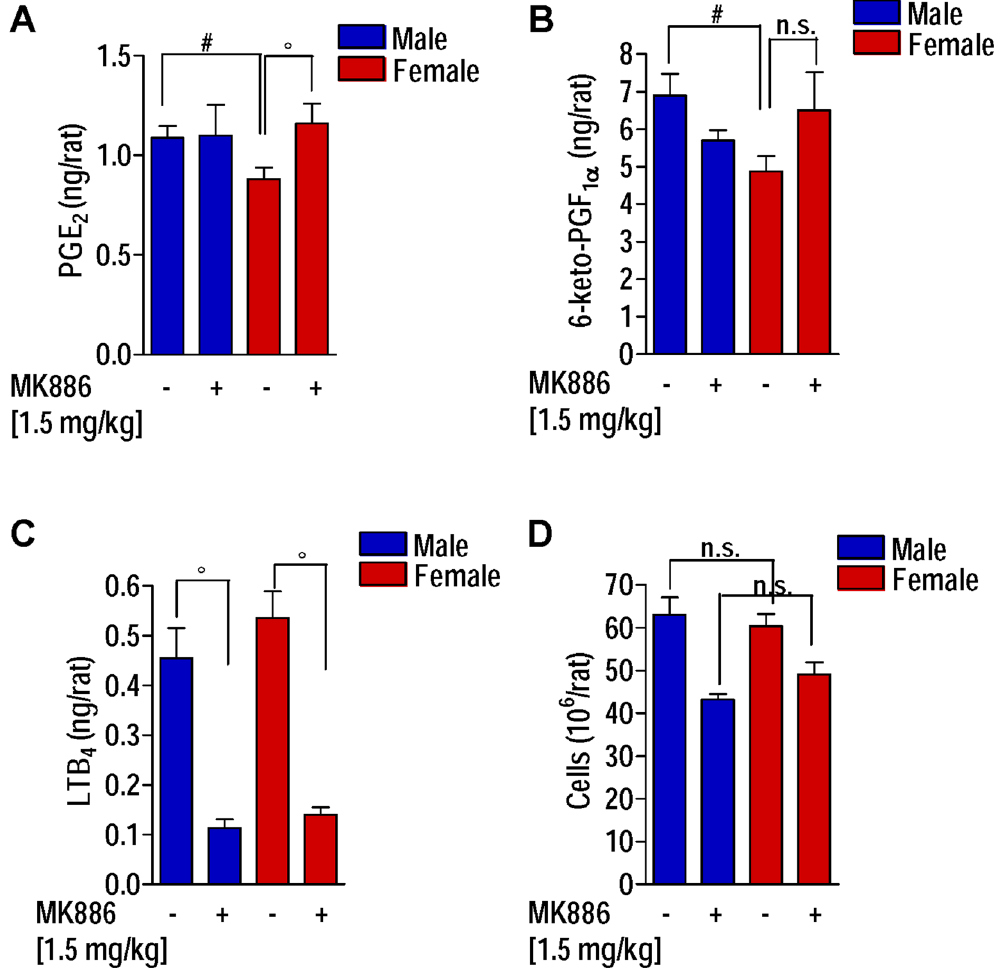
Figure 4. Inhibition of 5-LO product formation by MK886 abolishes the sex differences in PG formation in the thoracic exudates of carrageenan-treated rats. Rats were pre-treated with MK886 (1.5 mg/kg, i.p.) or vehicle (DMSO 2%, i.p.) 30 min prior to carrageenan intrathoracic injection and sacrificed after 4 hrs. ( A ) PGE 2 , ( B ) 6-keto-PGF 1 α , and ( C ) LTB 4 levels in the exudates. ( D ) Number of infiltrated cells. Values represent means ± S.E.M; n = 6 rats; # p < 0.05, male vs female; ° p < 0.05, female control rats vs female rats treated with MK886; two-tailed Student’s t